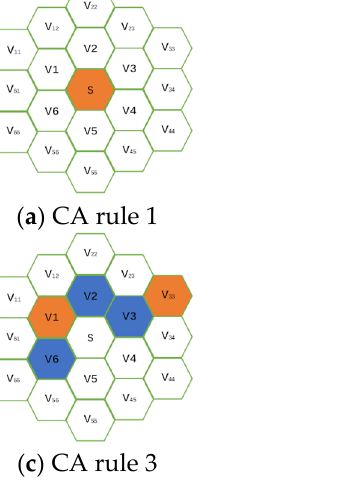
Figure 2. The rules of the CA model.